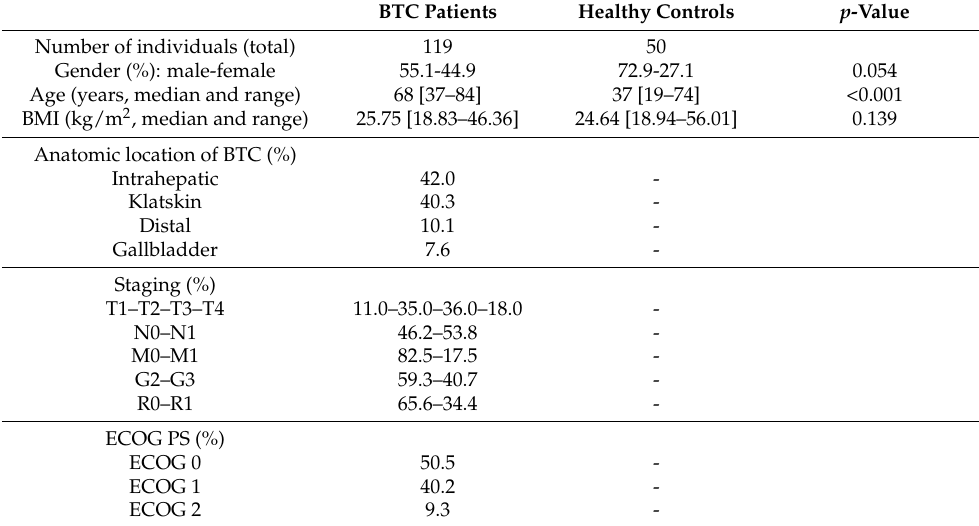
Table 1. Patient